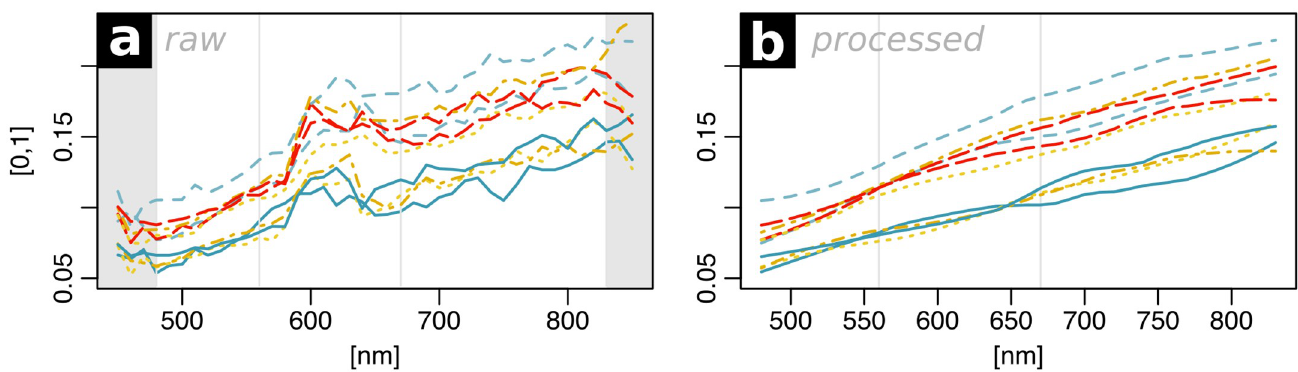
Fig 3. Spectral data before (a) and after (b) denoising. The signal was limited to the wavelength range of 480–830 nm and the bands between 560 and 670 nm were interpolated. The plot shows ten randomly selected spectra.